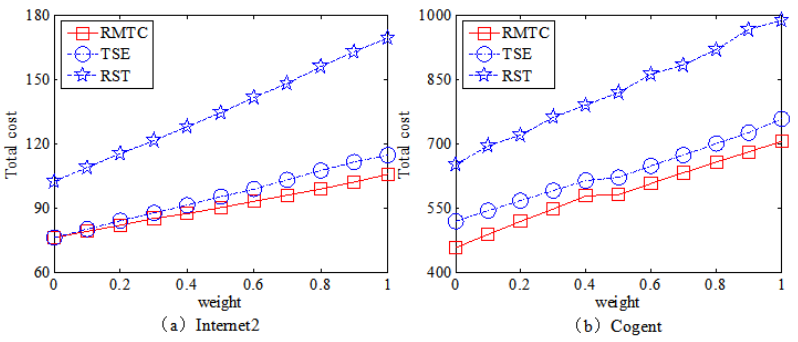
Figure 13. Impact of weight α from 0 to 1 in ( a ) Internet2, ( b ) Cogent.